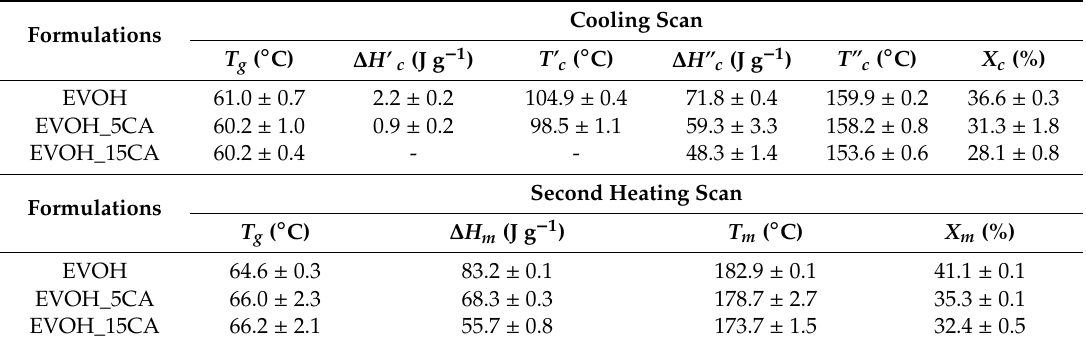
Table 2. Mechanical properties of EVOH based systems.